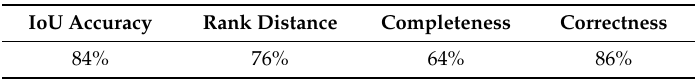
Table 7. Accuracy indices calculated for the Grand Erg Oriental